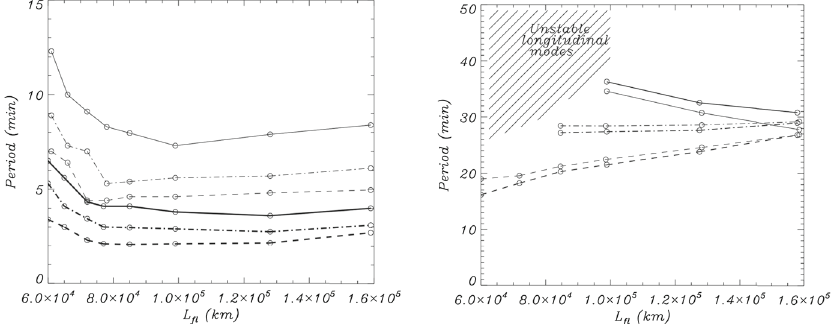
Fig. 58 Period of vertical (left panel) and horizontal (right panel) oscillations of the two-dimensional prominencemodelofTerradasetal.(2013)versusthelengthofthefieldlinepassingthroughtheprominence centre. Solid, dash-dotted and dashed lines correspond to the prominence mass per unit length (in the ignorable direction) equal to 5 . 4 × 10 5 , 2 . 7 × 10 5 and 1 . 3 × 10 5 kg km − 1 , respectively. Thin/thick curves are associated with v A0 = 10 c s0 and v A0 = 20 c s0 , respectively, where v A0 and c s0 denote the Alfvén and sound speeds at the prominence centre. The hatched area on the right panel shows the instability region of horizontal modes. Image reproduced with permission from Terradas et al. (2013), copyright by